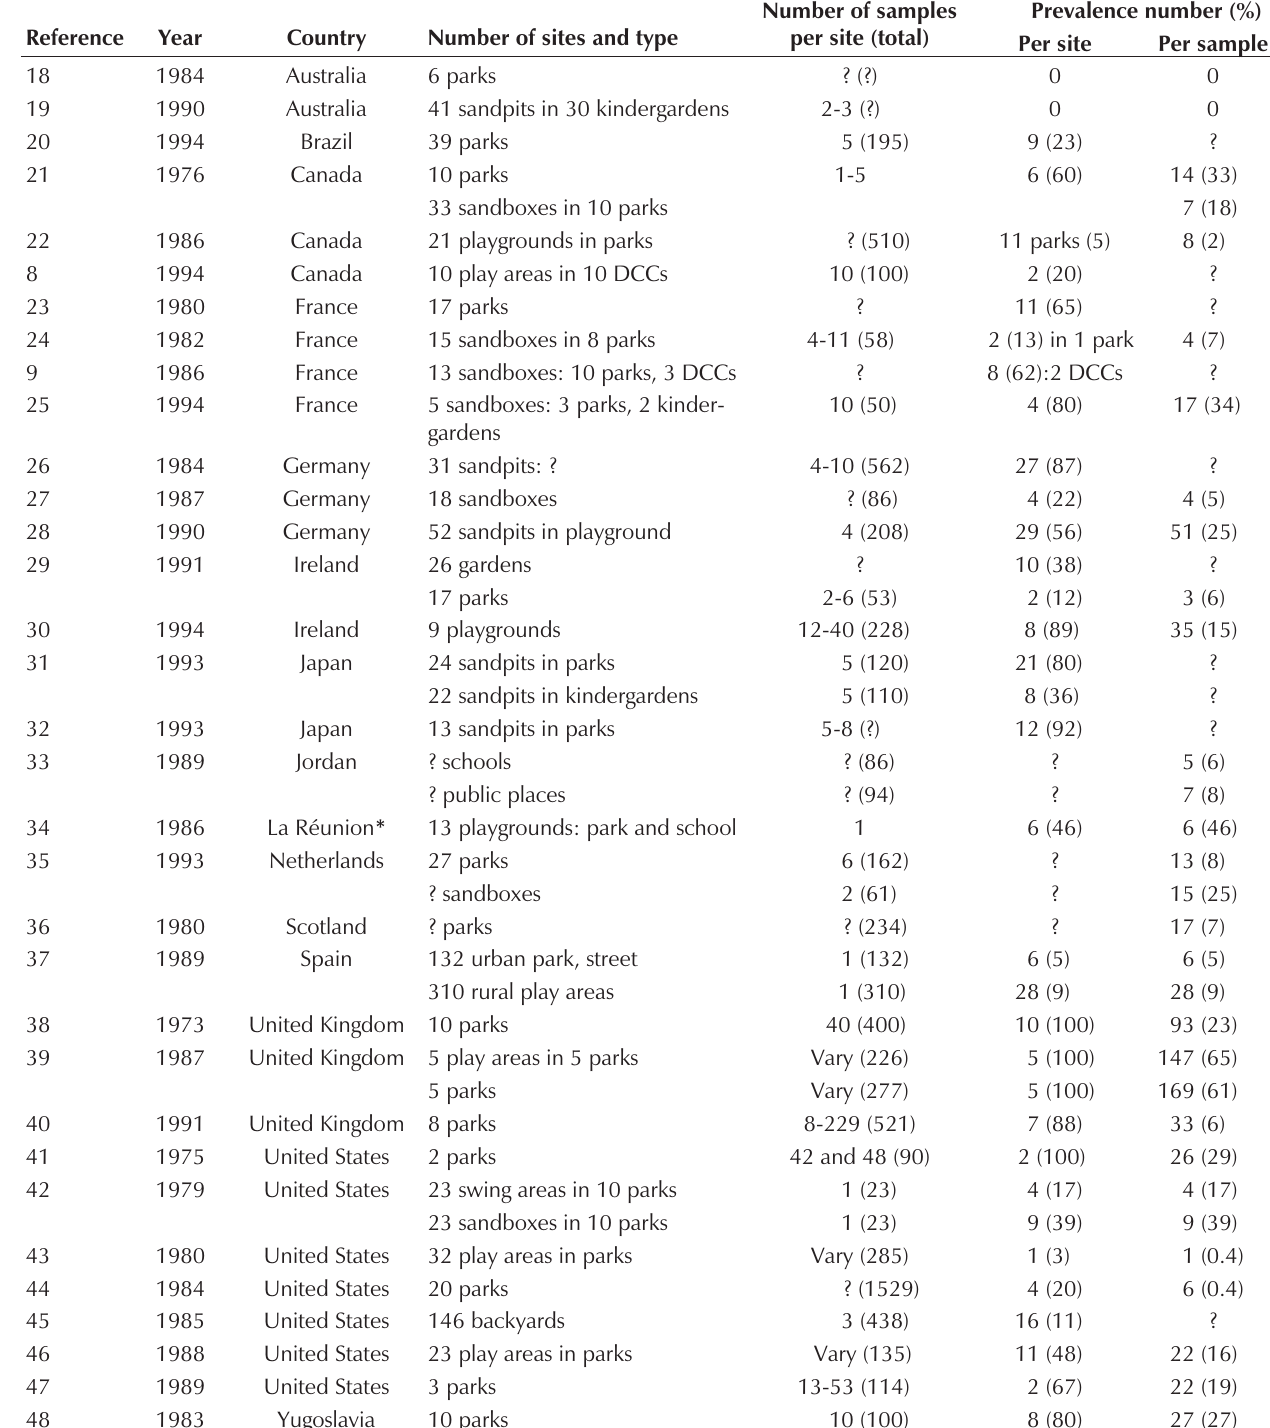
Reported prevalence of Toxocara species in outdoor environments by